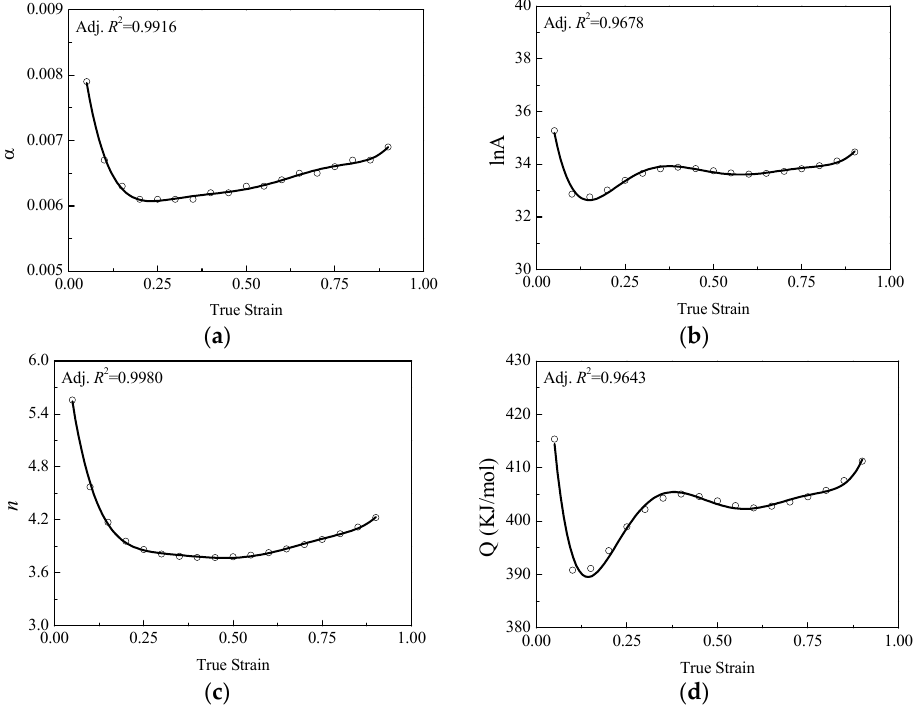
Figure 6. Relationships between: ( a ) α ; ( b ) ln A ; ( c ) n ; and ( d ) Q and true strain ε by polynomial fit.